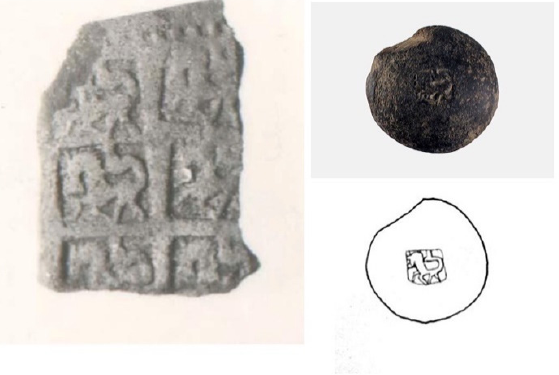
Figure 4. PC19710594 (left) and PC19680113 (right) detailing the use of the same horse stamp on an Orientalizing drinking vessel and a rocchetto head, ca. 675/650-600 BCE.